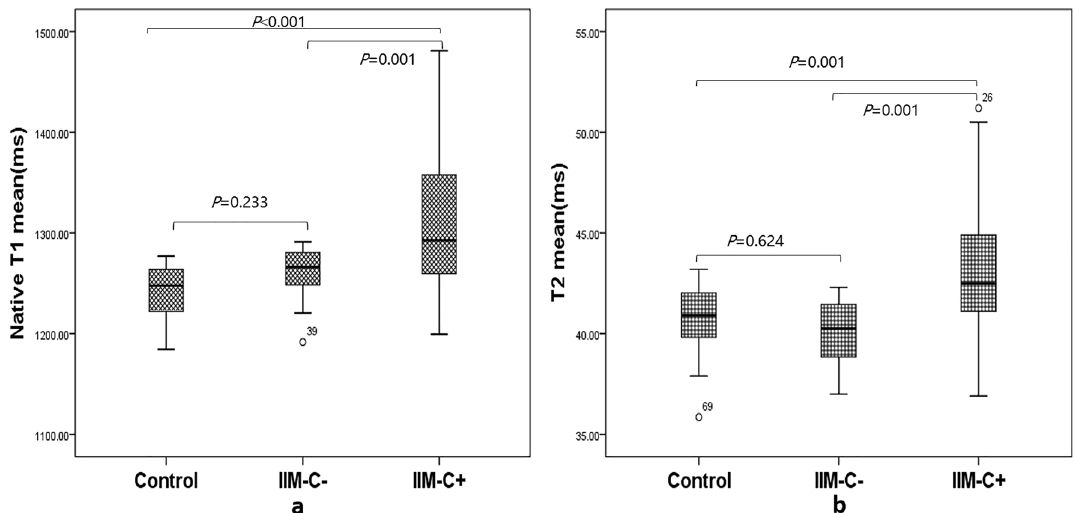
Figure 3. Boxplots showing the values of native T1 mean ( a ) and T2 mean ( b ) in the three classes of subjects.